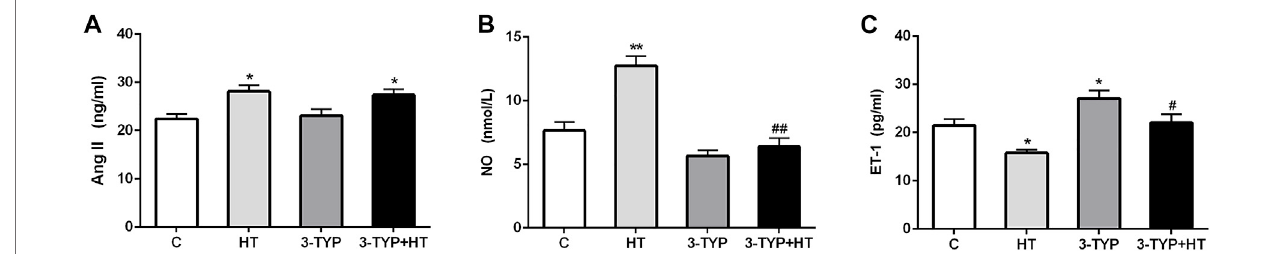
FIGURE 3 | Changes of vasodilation capacity in serum after Sirt3 inhibition and hypoxic training interventions. (A) , (B) and (C) were comparisons of Ang II (ng/ml), NO (nmol/L), and ET-1 (pg/ml) levels, respectively. C, control; HT, hypoxic training; 3-TYP, Sirt3 inhibitor 3-TYP; 3-TYP + HT, 3-TYP + hypoxic training. n = 6. * p < 0.05, ** p < 0.01 vs. C; # p < 0.05, ## p < 0.01 vs. HT. All the results were presented as mean ± SEM.